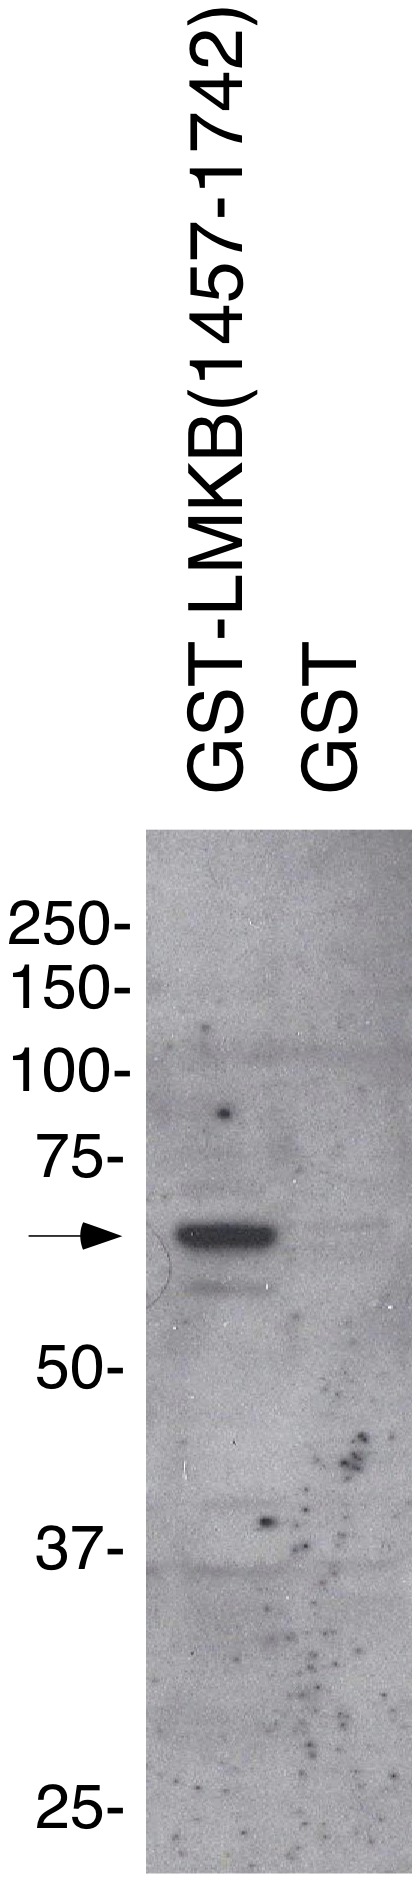
Antibodies in the serum of patient 0081 react with LMKB.The human serum contained antibodies directed against GST-LMKB amino acids 1457–1742, but did not react with GST alone. Black arrow indicates location of the GST-LMKB fusion protein.